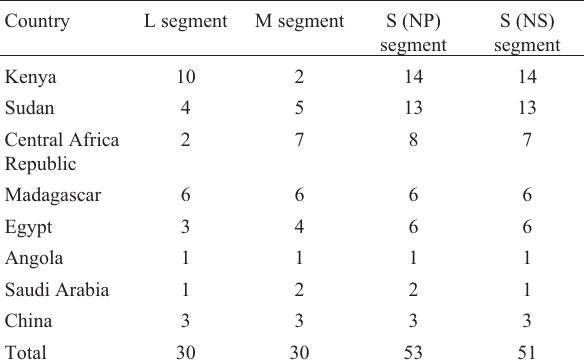
Table 1 - Summary of RVFV sequence characteristics.